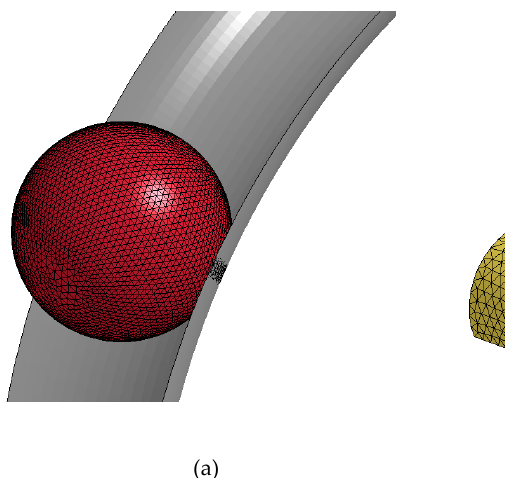
Figure 13. The impact forces by FE explicit analysis.